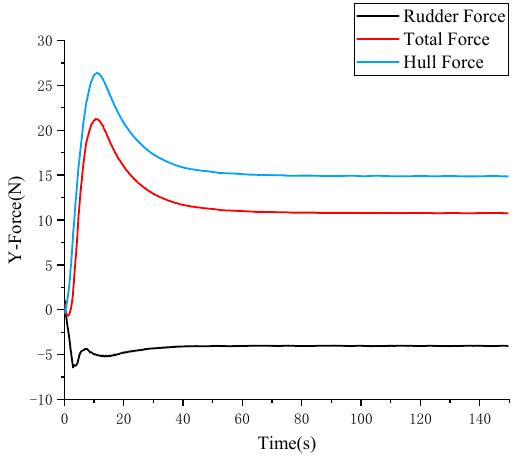
Figure 14. Force in +35° Y direction.